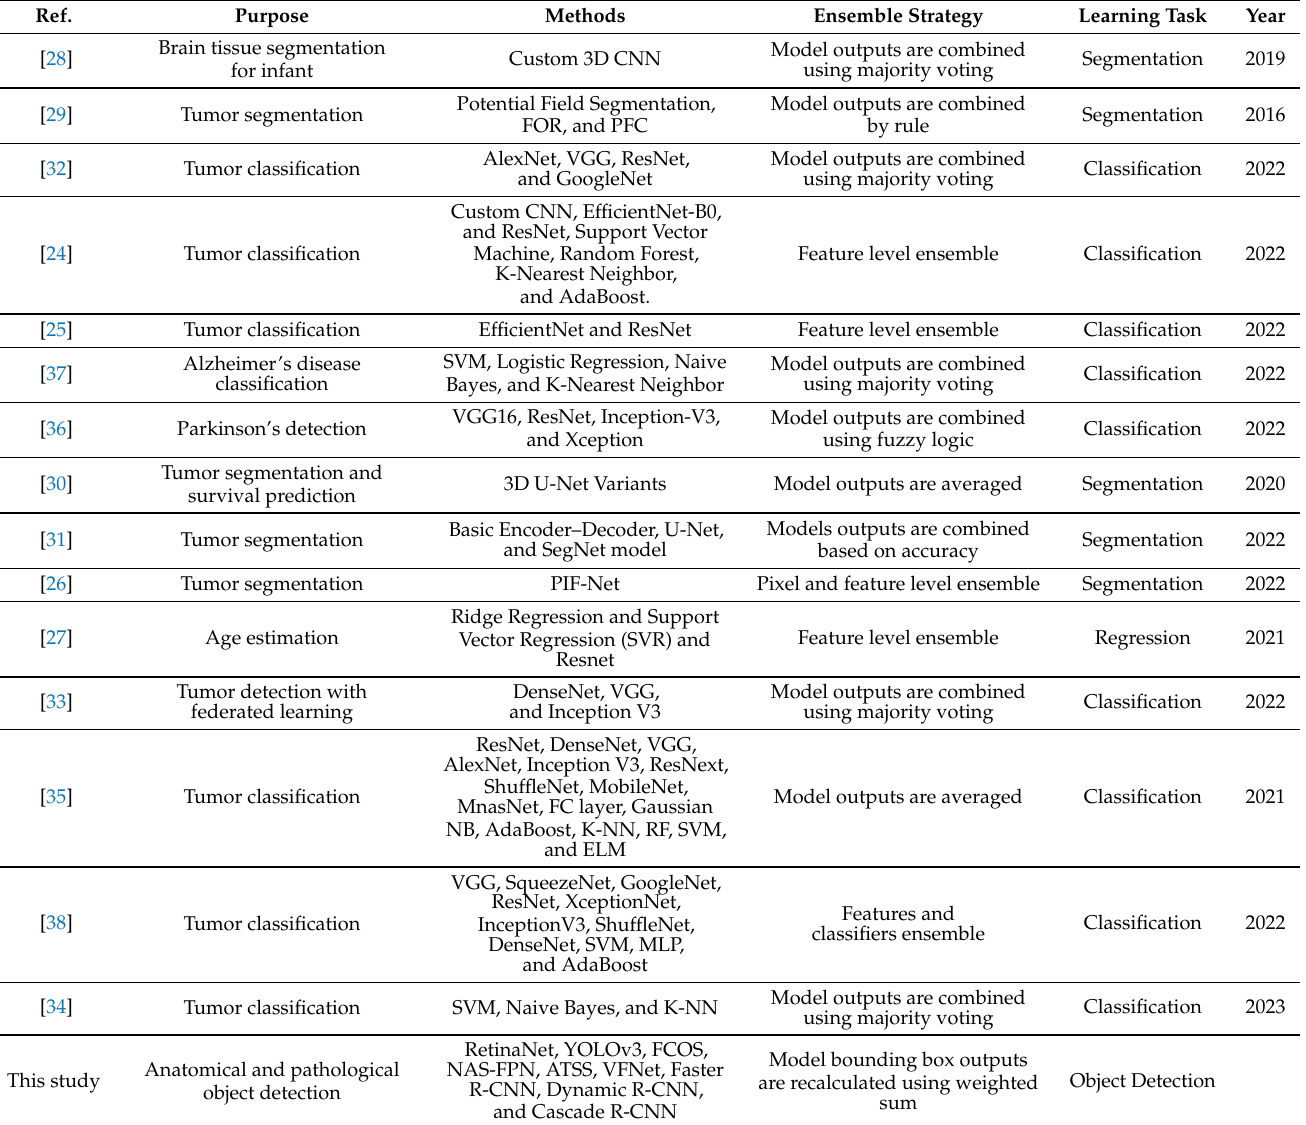
Table 1. Current studies in the brain MRI literature using ensemble